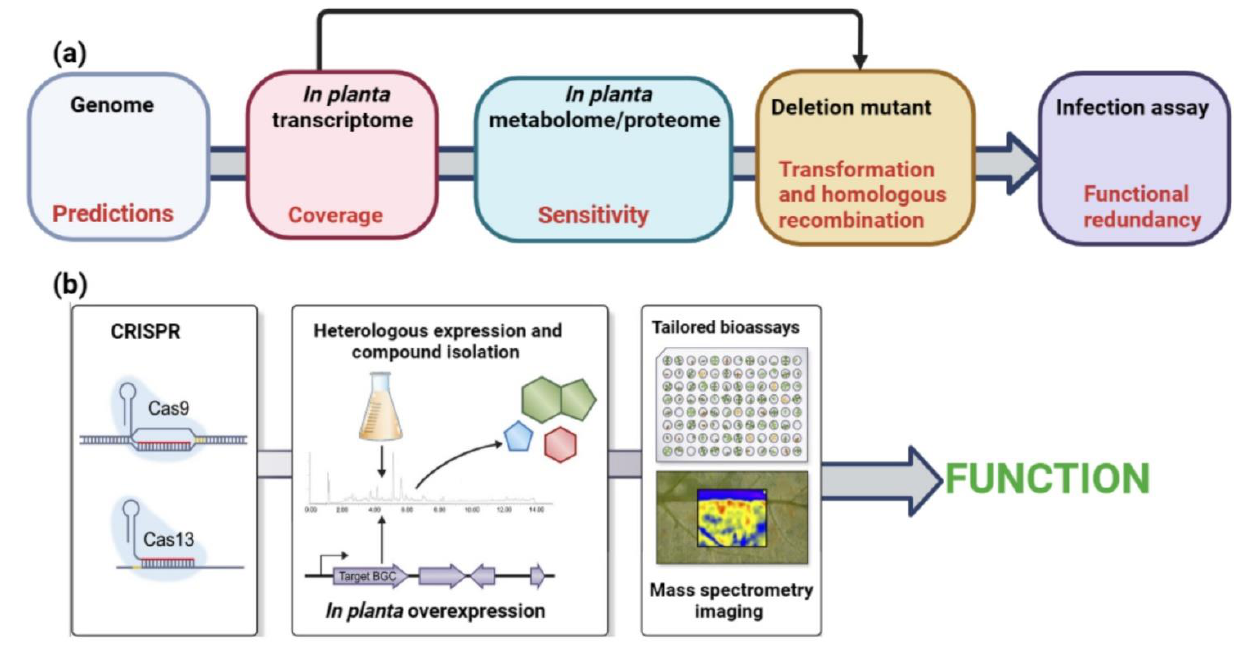
Figure 4. Integrated approaches to elucidate the biological functions of fungal SM and sRNA effectors during plant-fungal pathogen interactions. ( a ) The most common approach begins with genome mining integrated with in-planta transcriptome analysis (and/or in-planta proteome/metabolome analysis), which gives potential candidate genes to delete and test for a function in plant colonization. Following these functional tests, plant targets are identified. Each of these steps has bottlenecks (text in red), which necessitate the consideration of complementary or alternative options. Improved bioinformatic prediction of gene composition is critical for secondary metabolite gene clusters in particular. In-planta-omics approaches suffer from fungal material dilution in a complex plant sample. Transformation and homologous recombination continue to be the most significant barriers to